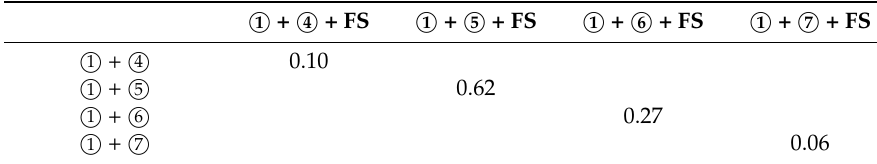
Table 12. The chi-square values of McNemar tests for land cover classification in complex surface-mined landscapes using spectral bands and some types of feature sets with feature selection: 1 (cid:13) : spectral bands; 4 (cid:13) : the Gaussian low-pass filters; 5 (cid:13) : the mean filters; 6 (cid:13) : the standard deviation filters;